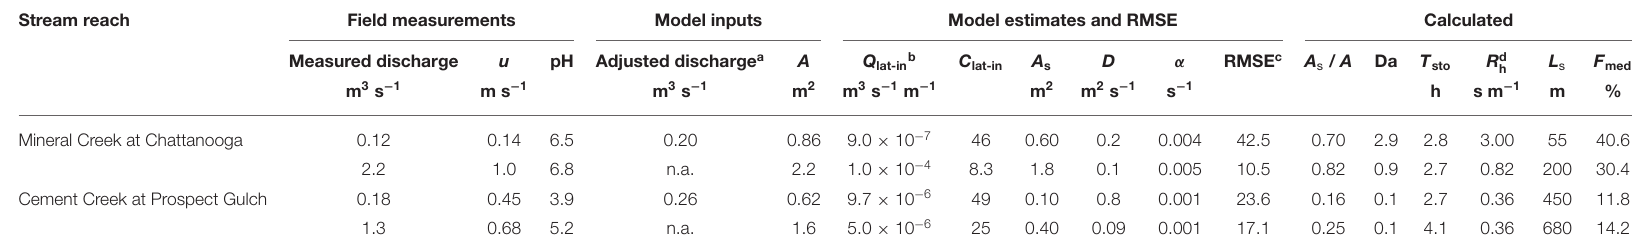
u, stream velocity; A, stream cross-sectional area; Q lat − in , discharge of lateral inflows; C lat − in , concentration of lateral inflows; A s , transient storage zone cross-sectional area; D, dispersion; α , mass transfer rate; Da, Damkohler number; T sto , storage zone residence time; R h , hydraulic retention factor; L s , average distance a solute travels before entering the storage zone; F med , median travel time resulting from transient storage. a For both low-flow model runs, the discharge was adjusted to account for a lag in the arrival time of the modeled breakthrough curve. b The boundary condition for Q lat − out (m 3 s − 1 m − 1 ) was set to 0.